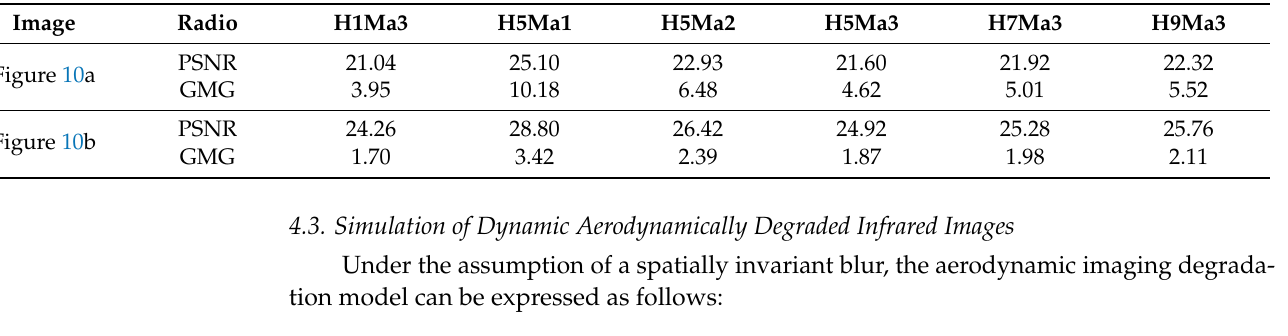
Figure 10. Original image ( a ) with the complex background; original image ( b ) with simpler back- ground and target; distorted imaging result ( c , d ). Table 4. PSNR and GMG of distorted images with the changes in flight speed and